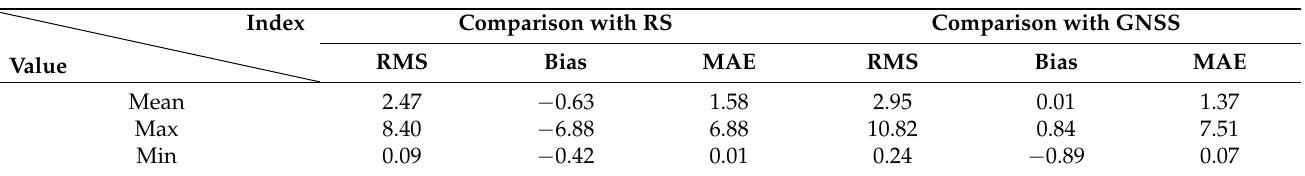
Table 5. Statistical results of RMS, Bias, MAE of PWV differences between Sentinel-3A and